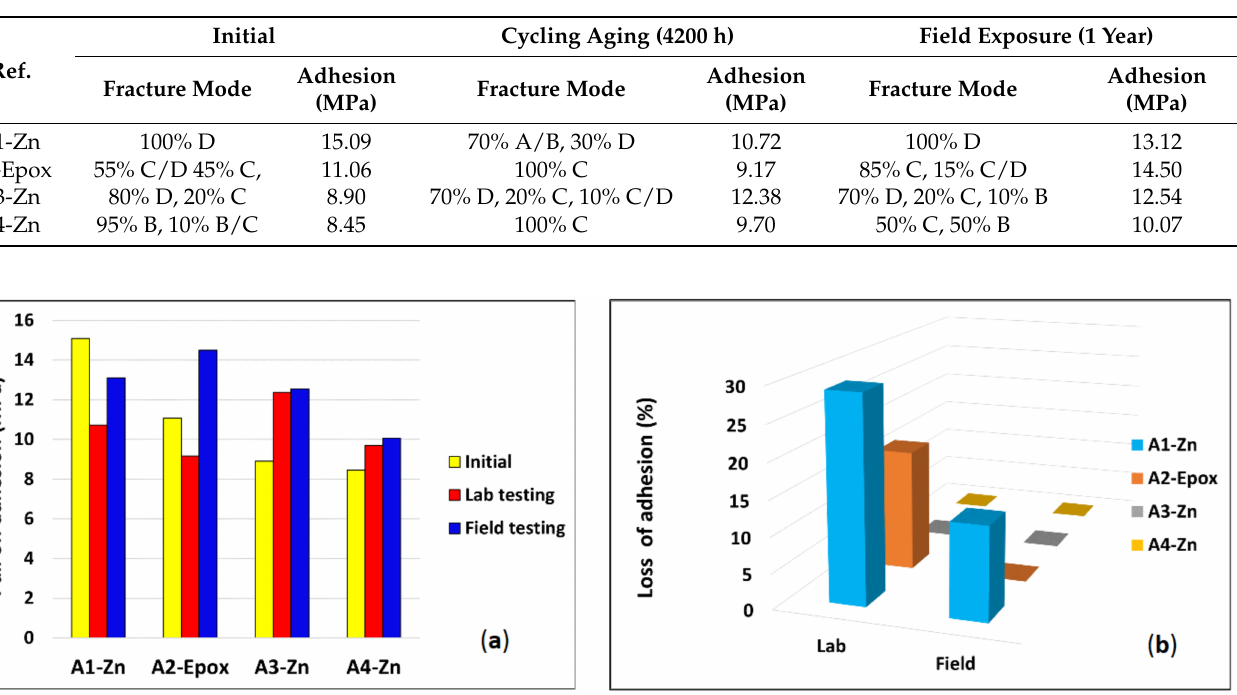
Table 7. Adhesion strength (average) of coating systems for atmospheric zone before and after aging and field exposure.